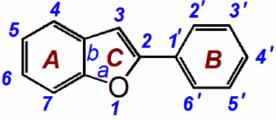
Figure 1. The scaffold of 2-phenyl-benzofurans.